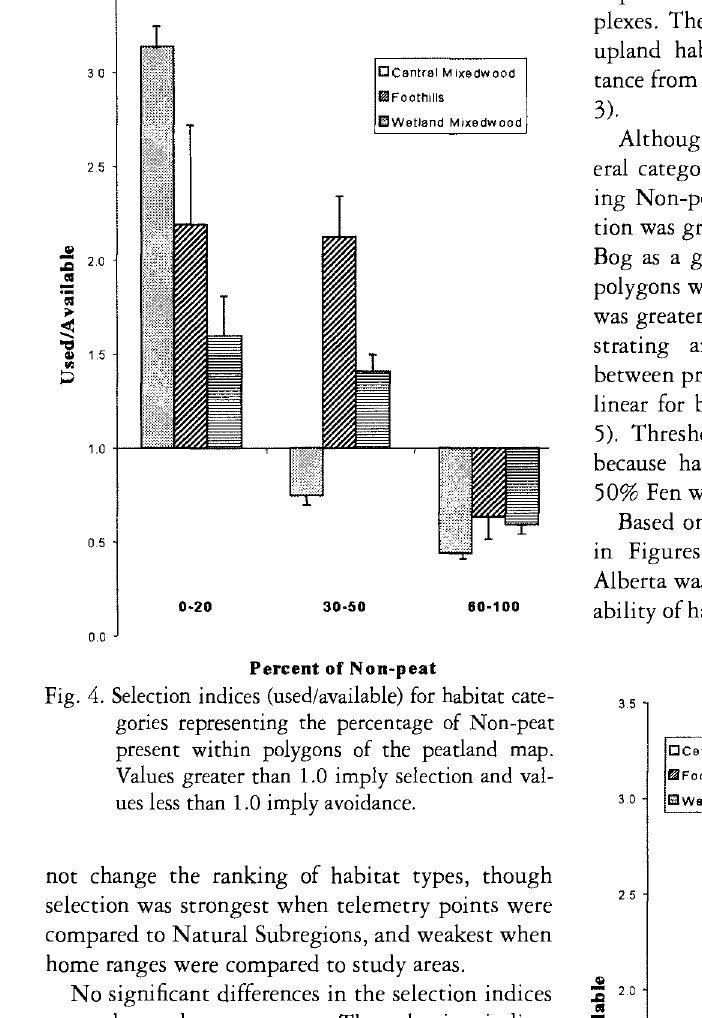
Fig. 4. Selection indices (used/available) for habitat cate gories representing the percentage of Non-peat present within polygons of the peatland map. Values greater than 1.0 imply selection and val ues less than 1.0 imply avoidance.